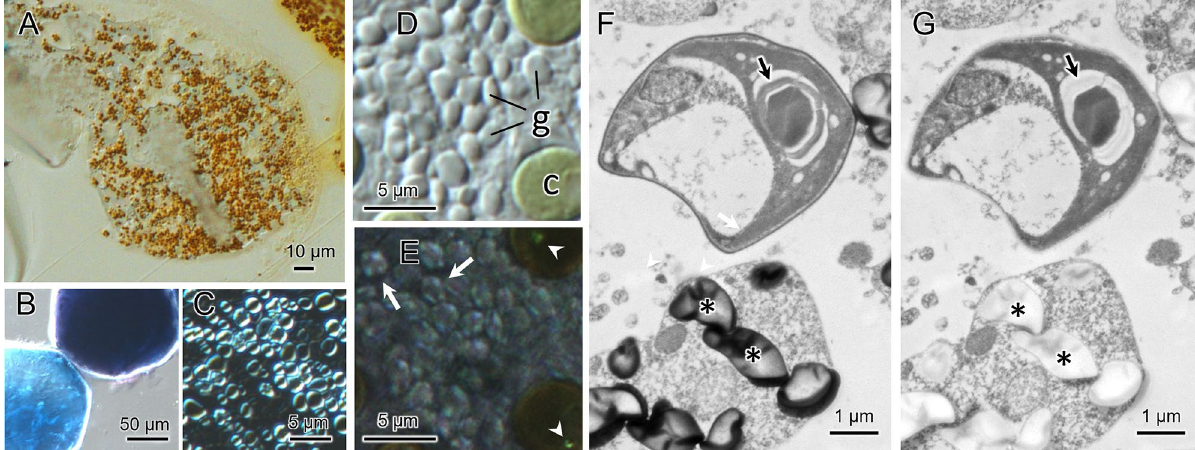
Figure 4. Histochemical localization of starch in Stentor pyriformis . ( A ). Light micrograph of a thick section of a Spurr’s resin-embedded cell stained with Lugol’s solution. Cytoplasmic granules stained brown, suggesting high content of α-1, 6-linked glucose branch. ( B ): Potato starch granules stained with Lugol’s solution shown as comparison. Potato starch stains blue due to its high amylose content. ( C ): A DIC image of the freshly isolated cytoplasmic granules observed under the crossed polarizer condition, showing that the granules have a high refractile index. ( D ) and ( E ). Polarization microscopy of starch granules in S. pyriformis . ( D ). DIC image of compressed and disrupted cytoplasm of S. pyriformis . Symbiotic Chlorella (c) and cytoplasmic granules (g) are shown. ( E ). Polarization micrograph of the same area as shown in D under the cross-nicol condition. In the crossed polarizer orientation, birefringent anisotropic specimens such as plant starch grains show a characteristic “Maltese cross” pattern (see Olympus website: https ://www.olymp us-lifes cienc e.com/en/ micro scope -resou rce/prime r/techn iques /dic/dicph aseco mpari son/). The cytoplasmic granules of S. pyriformis show a Maltese cross pattern (arrows), indicating that the granules have birefringent properties like plant starch. Arrowheads show birefringence signals of the starch sheath in symbiotic Chlorella cells. ( F ) and ( G ): Transmission electron micrographs of a section of S. pyriformis chemically fixed and stained with lead and lanthanoid. Photographs of the same section were taken before ( F ) and after ( G ) treatment with Lugol’s iodine solution. Arrows indicate the pyrenoid starch sheath, which was stained with heavy metals in F, but the stain was removed by iodine treatment. Granules in the ciliate cytoplasm (asterisks) were also destained by iodine treatment.